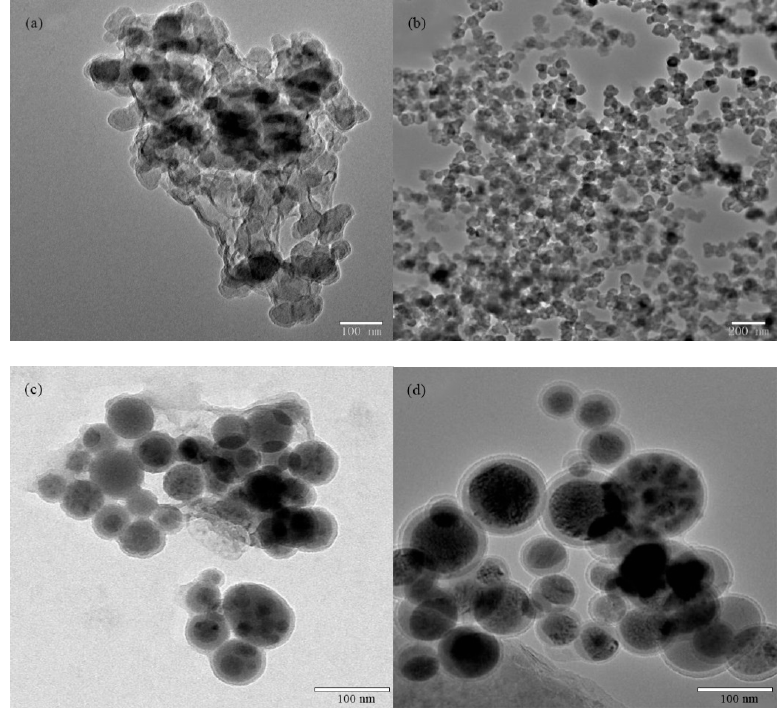
Figure 1. TEM micrographs of ( a ) Nano-SiO 2 , ( b , c ) modified Nano-SiO 2 , and ( d ) Si/F polyacrylate